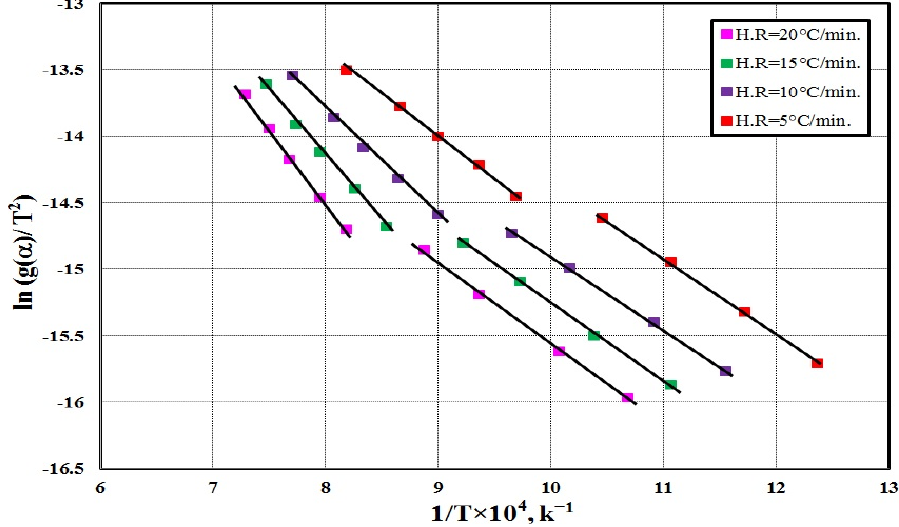
Figure 9. Coats-Redfern plot of composite I at two weight loss stages .